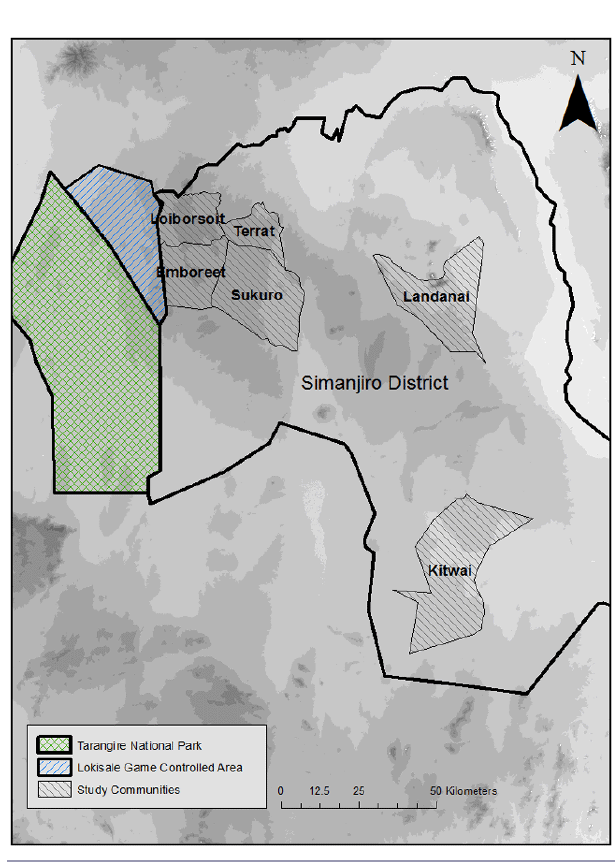
Fig. 1 . Map of study area.